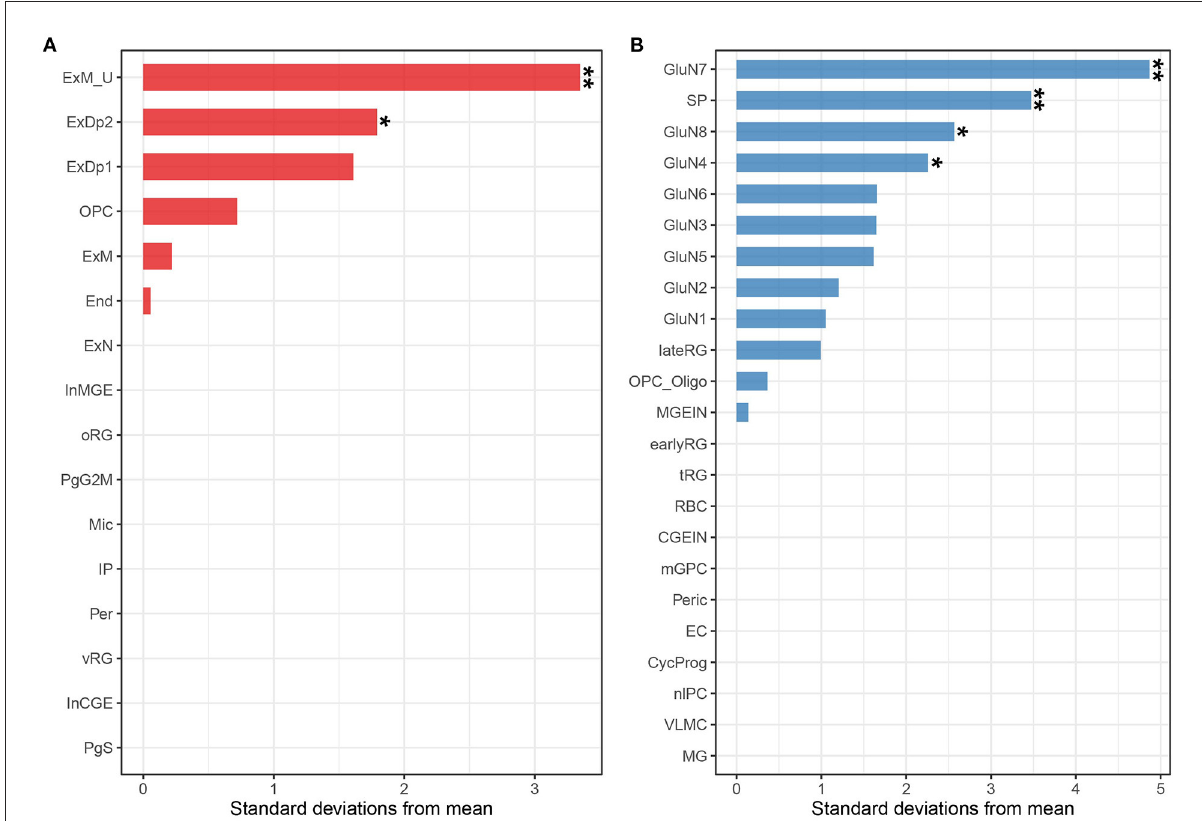
FIGURE4 Associations between ADHD and cell types from the human fetal neocortex using scRNA-seq data from Polioudakis et al. (22) (A) and Trevino et al. (23) (B) . Tissues labeled with two asterisks indicate Bonferroni adjusted significance ( P < 0.05 for the Polioudakis et al. (22) data; P < 0.05 for the Trevino et al. (24) data). Tissues labeled with one asterisk indicate the nominal significance ( P < 0.05). End, endothelial cell; ExDp1, excitatory deep layer 1; ExDp2, excitatory deep layer 2; ExM, maturing excitatory; ExM-U, maturing excitatory upper enriched; ExN, migrating excitatory; InCGE, interneuron; InMGE, interneuron MGE; IP, intermediate progenitor; Mic, microglia; OPC, oligodendrocyte precursors; oRG, outer radial glia; Per, pericyte; PgG2M, cycling progenitors (G2/M phase); PgS, cycling progenitors; vRG, ventricular radial glia; GluN, glutamatergic neuron; SP, subplate; nIPC, neuronal intermediate progenitor cell; lateRG, late radial glia; earlyRG, early radial glia; VLMC, leptomeningeal cells; tRG, truncated radial glia; RBC, red blood cells; Peric, pericytes; OPC_oligo, OPC and oligodendrocyte; mGPC, multipotent glial progenitor; CycProg, cycling